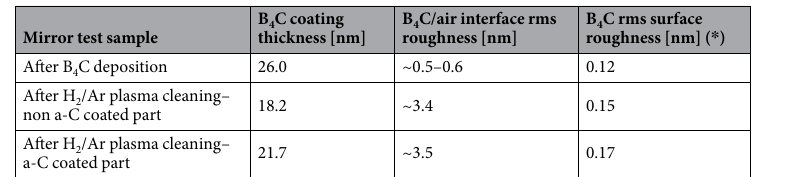
Table 4. Results from the IMD simulations of the XRR measurements as shown in Fig. 6 (bottom rows) as well as from reference measurements from a non-processed sample (top row). ( * ) Surface roughness values from interference